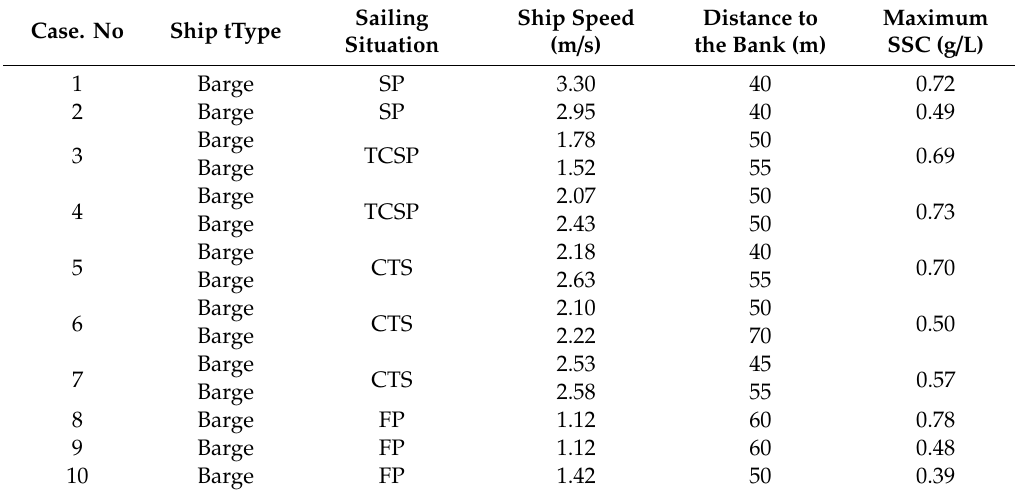
Table 2. SSC changes caused by the di ff erent ship passage